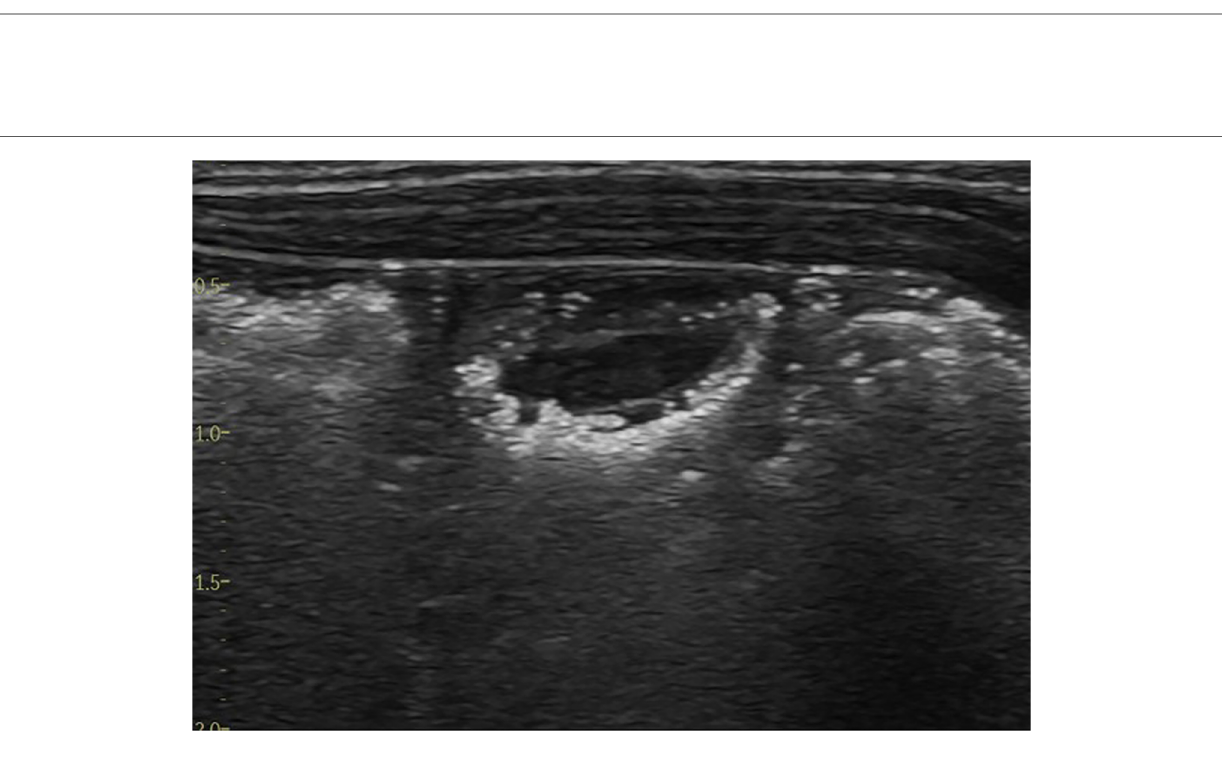
FIGURE 7 The sonographic appearance of intramural gas trapping — pneumatosis intestinalis, which is seen as white echogenic